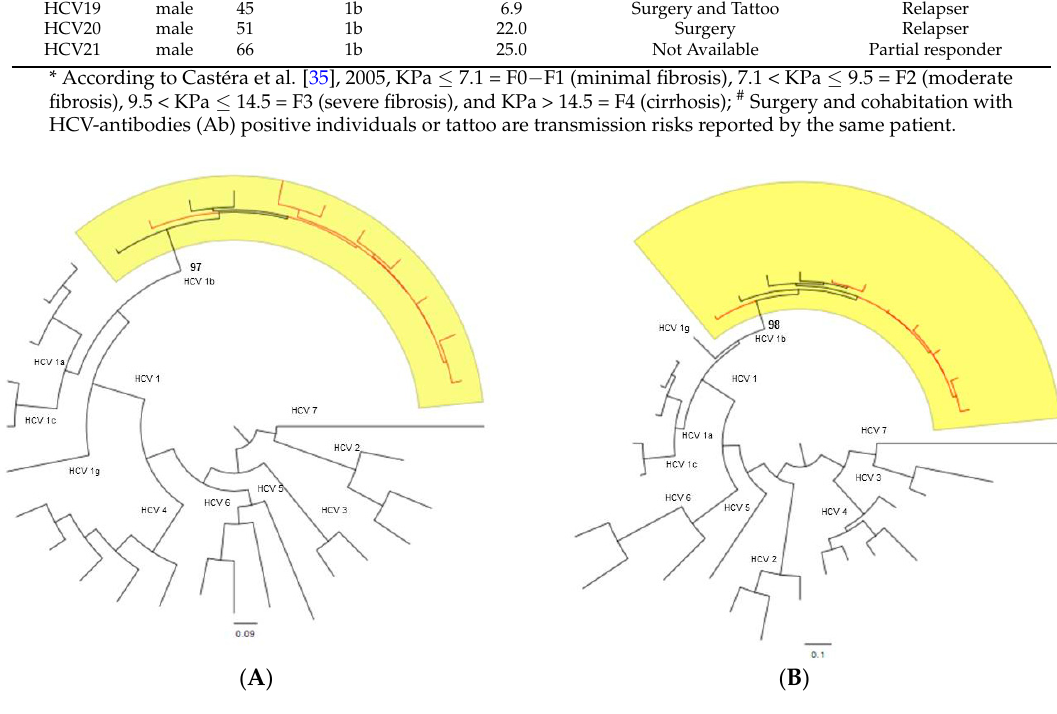
Figure 1. RAxML phylogenetic trees were estimated using 24 hepatitis C virus (HCV)